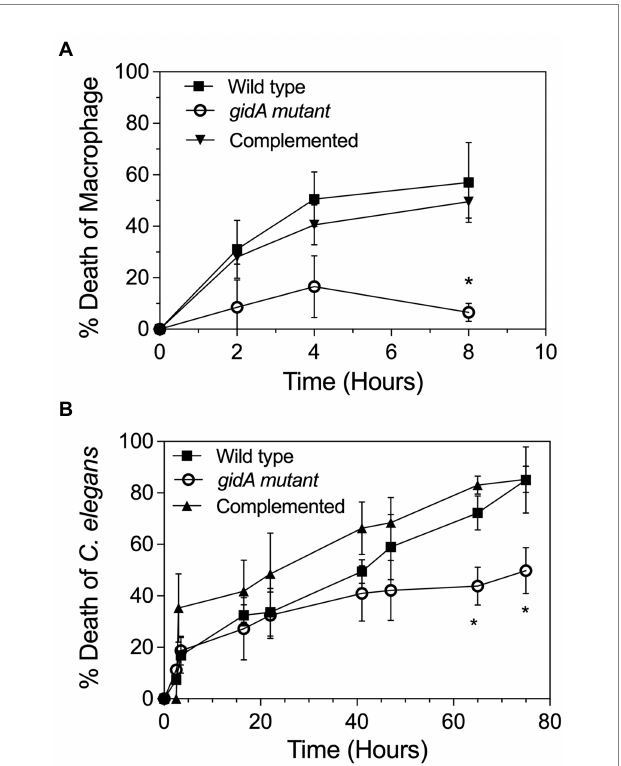
FIGURE 5 gidA is needed for the full virulence of P. aeruginosa. (A) Cell viability of the RAW264.7 macrophage cell line after treatment with the wild-type, gidA mutant, and complemented cells for 24 h. Cell viability at each timepoint was examined and compared with that of the untreated cells. (B) L4 stage larvae of C. elegans were added to the lawn of the wild-type, gidA mutant, and complemented cells. Live and dead worms were counted at time intervals for 3 days. The wild type and gidA mutant carried the pBBR1MCS-4 plasmid as a vector control. The data represent the mean ± SD values of three biological replicates. The statistical analysis was performed using Graphpad Prism (GraphPad Software). Asterisks denote a significant difference in the one-way ANOVA (* p ≤